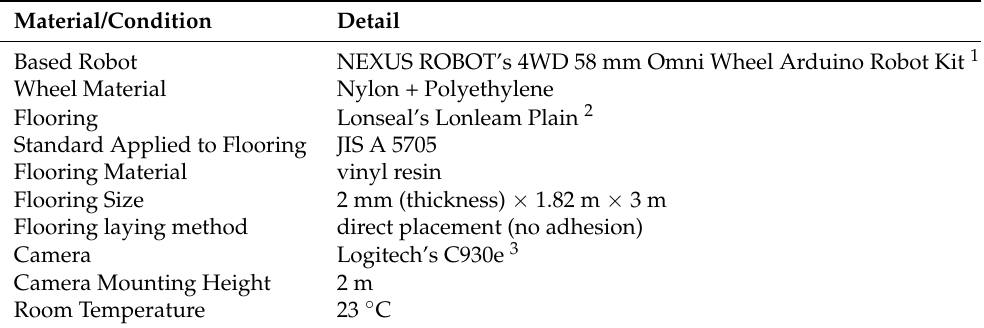
Table 1. The materials and conditions used in the